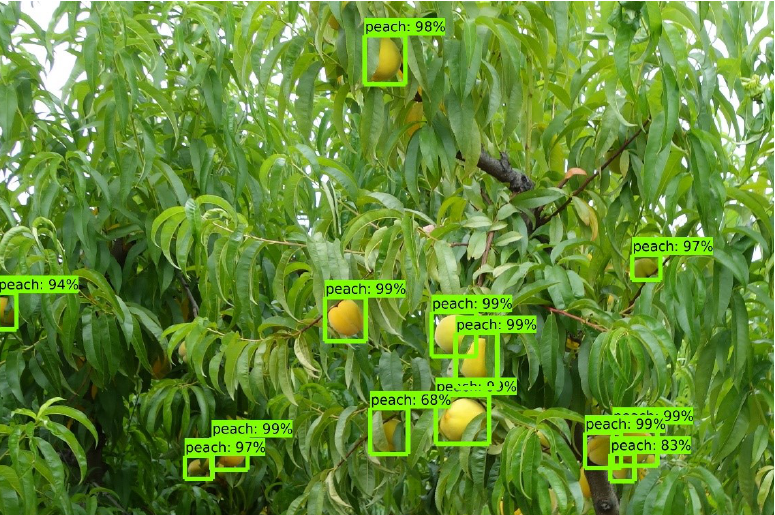
Figure 5. Detection of peaches in the image using Faster R-CNN model. Each bounding box contains peach and the score above the box shows the confidence score for each detected object [25].